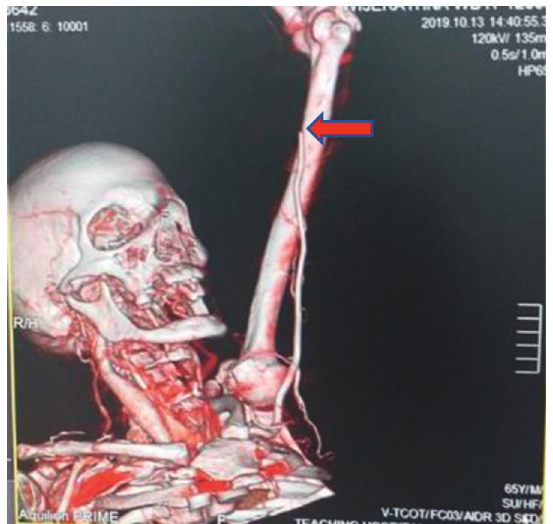
Figure 1: CTangiogram showing the left brachial artery occlusion (red arrow).